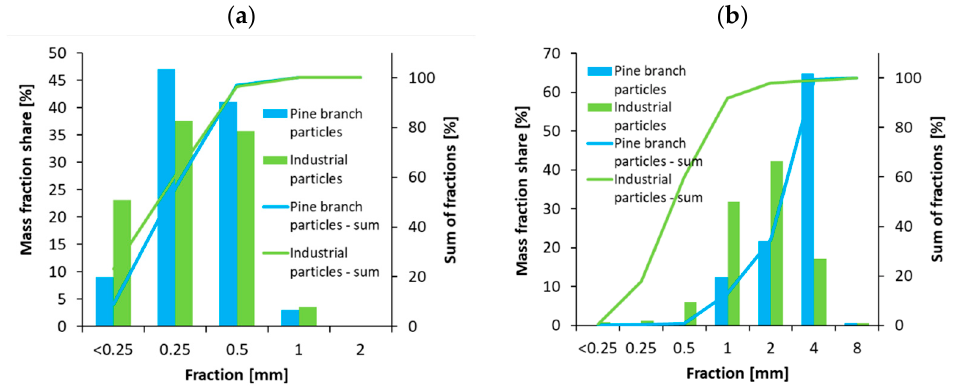
Figure 3. The fraction analysis results of the face ( a ) and core ( b ) layer particles.